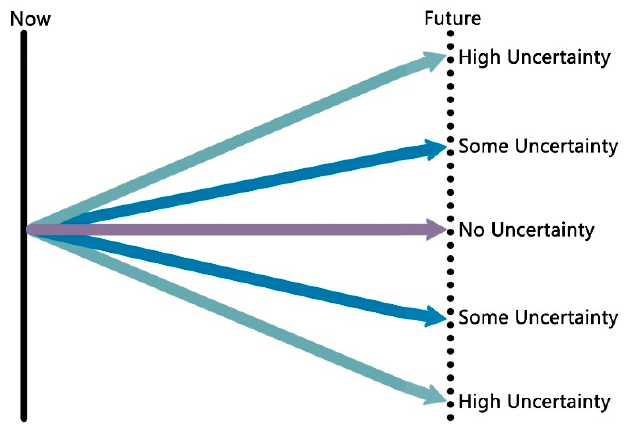
Figure 2. The pathways of uncertainties.